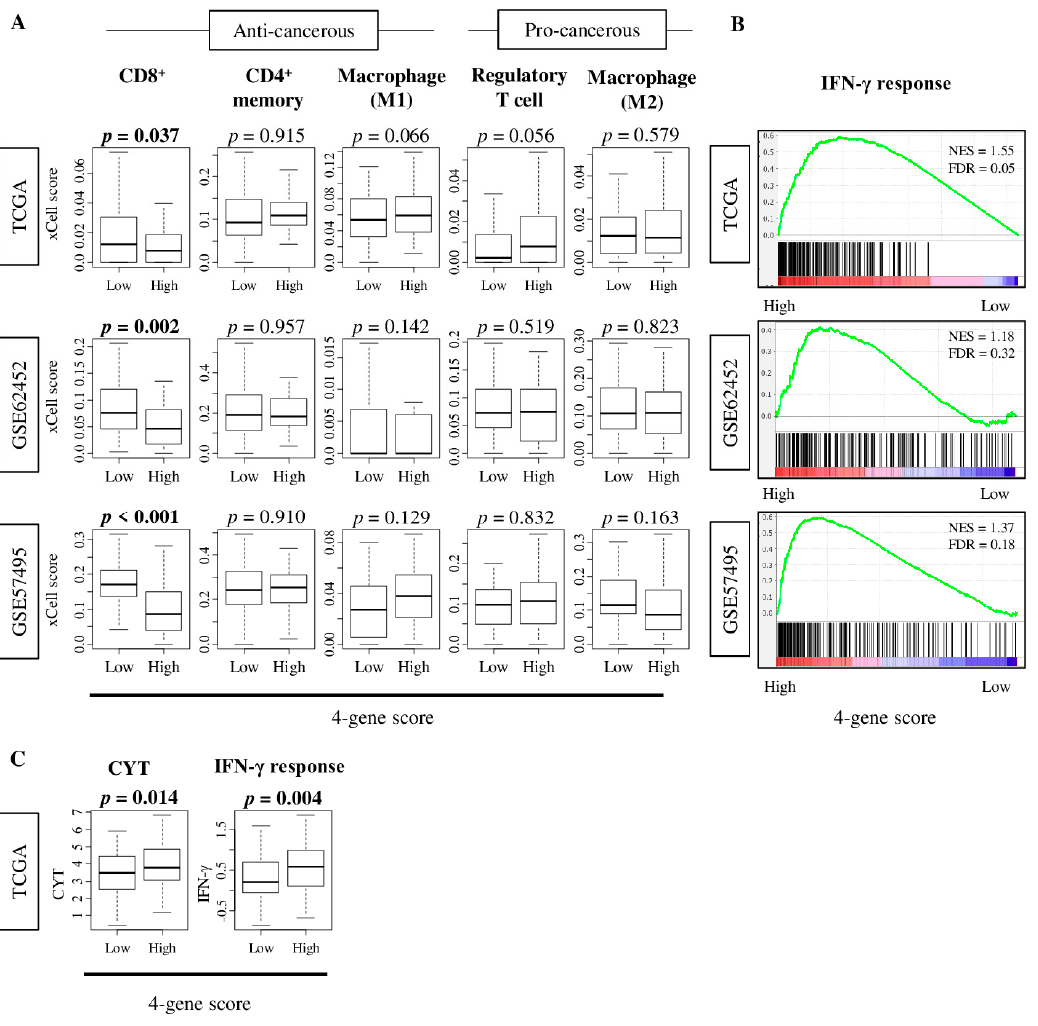
Figure 5. The association of the four-gene score with tumor-infiltrating immune cells and immune function scores in the TCGA, GSE62452, and GSE57495 cohorts. ( A ) Boxplots of the xCell scores of anti-cancerous immune cells—CD8 + T cells, CD4 + memory T cells, M1 macrophages, and pro-cancerous immune cells—regulatory T cells, and M2 macrophages, by low- and high-four-gene scores in three cohorts. A one-way ANOVA test was used to calculate p values. ( B ) Enrichment plot of the interferon (IFN)- γ response pathway of Hallmark gene sets using GSEA in three cohorts. NES and FDR were determined with the classical GSEA method, where FDR < 0.25 was considered significant. ( C ) Boxplots of the cytolytic activity score (CYT) and IFN- γ response score by low- and high-four-gene scores in the TCGA cohort. A one-way ANOVA test was used to calculate p values. Tukey-type boxplots showed median and interquartile level values.